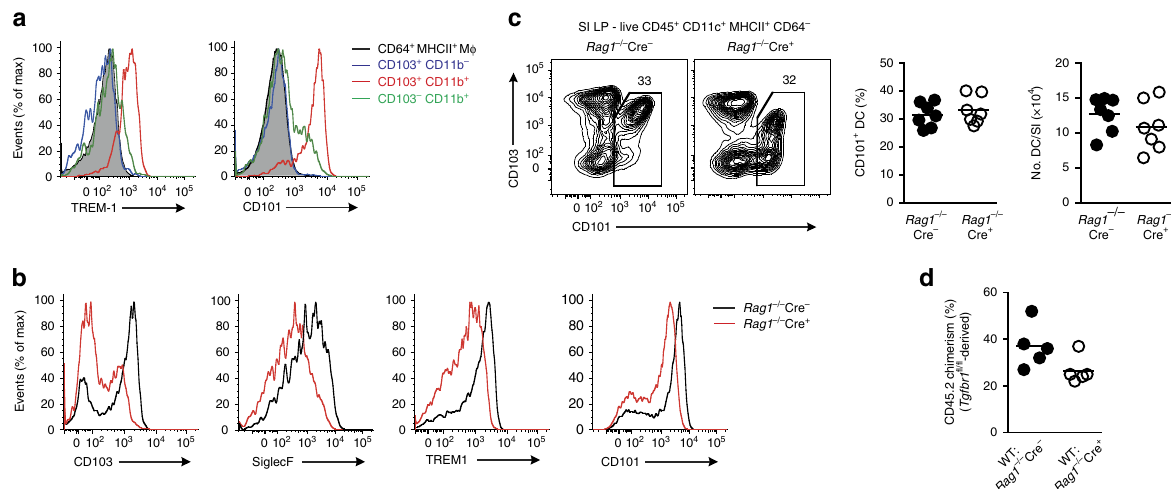
Fig. 6 CD101 and TREM1 are surrogate markers for intestinal CD103 + CD11b + DC. a Representative expression of TREM1 and CD101 by DC subsets and CD64 + MHCII + macrophages from SILP of Rag1 − / − Cre − mice. b Representative expression of CD103, SiglecF, TREM1 and CD101 by total CD11b + DC from the SILP of Rag1 − / − Cre − or Rag1 − / − Cre + mice. c Representative expression of CD103 and CD101 by total CD11c + MHCII + CD64 − DC ( left ) and the